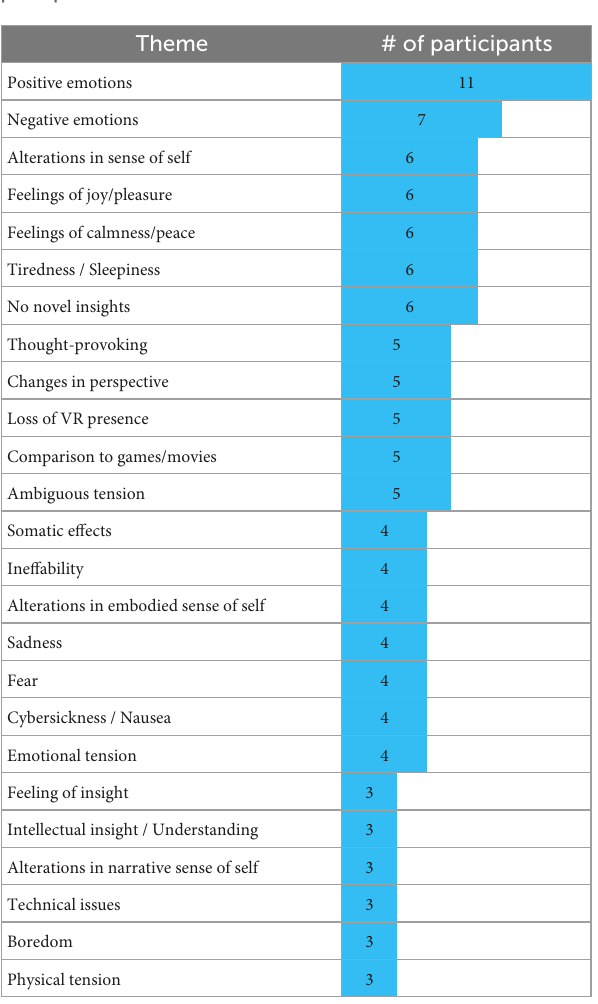
symptoms, with participants showing a significant reduction in depressive symptoms 2 weeks after the experiments. As this was an open-label feasibility study with a relatively small number of participants, strong conclusions about the efficacy of such